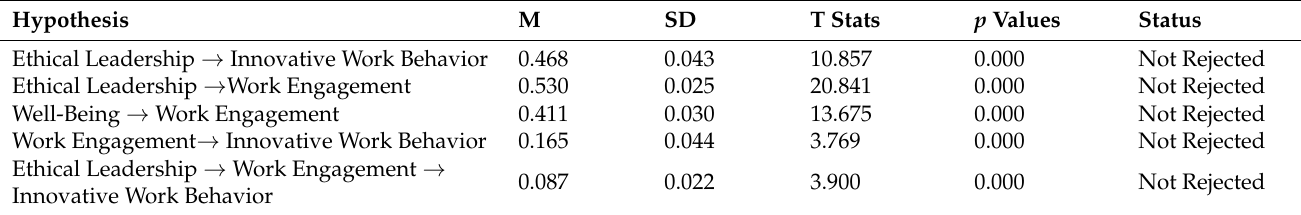
Table 8. Direct and Indirect